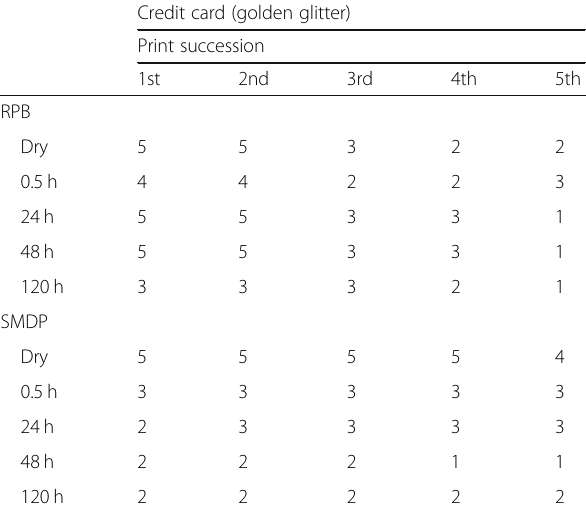
Table 5 Development of submerged and successive prints on Credit card (golden glitter) using Robin powder blue and Silver magnetic dual powder